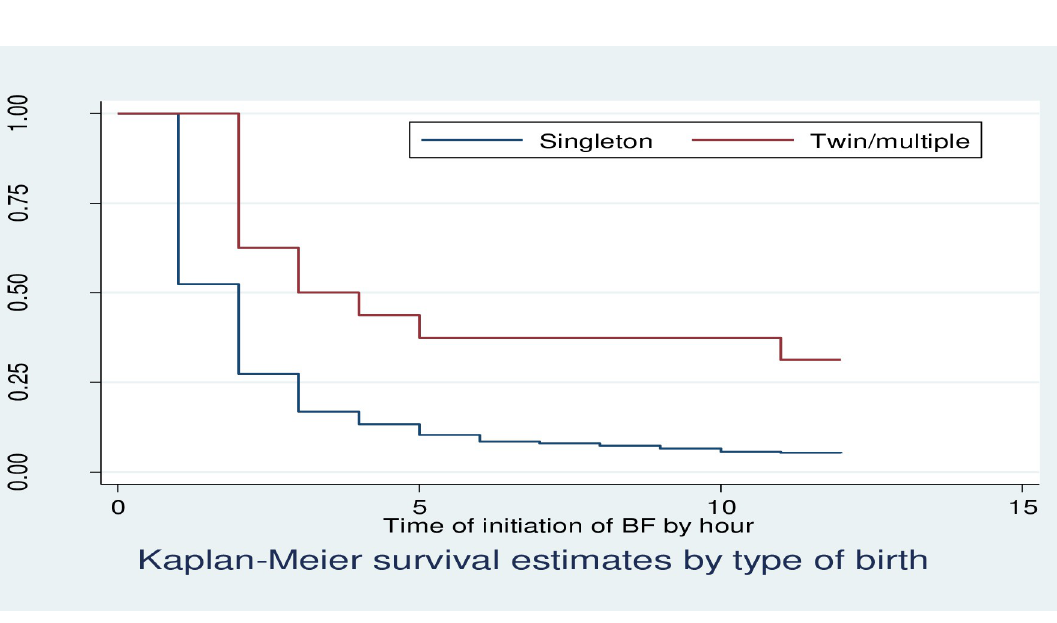
PLOS ONE | https://doi.org/10.1371/journal.pone.0268558 August 16,